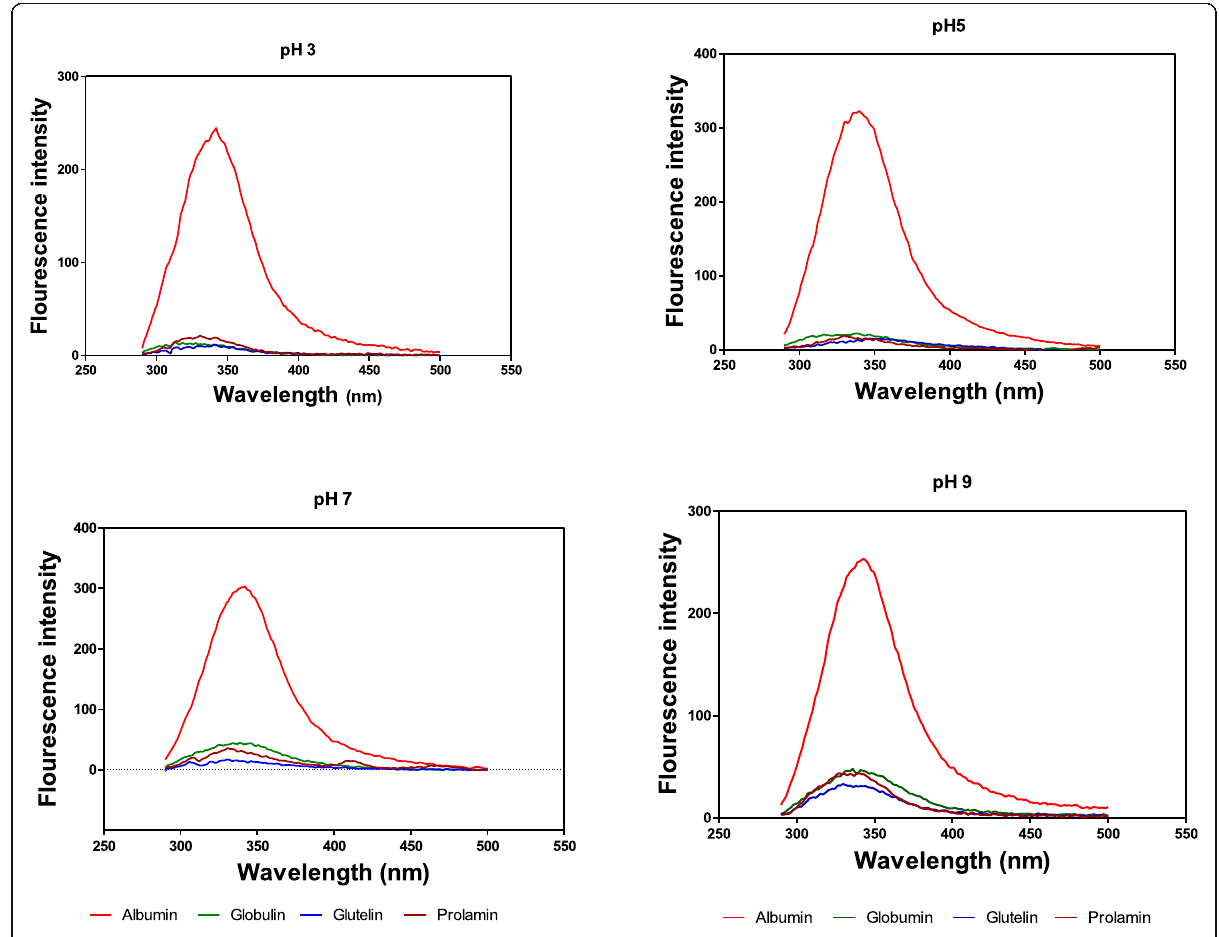
Fig. 2 Fluorescence intensity chromatograms of sesame protein fractions at various pH